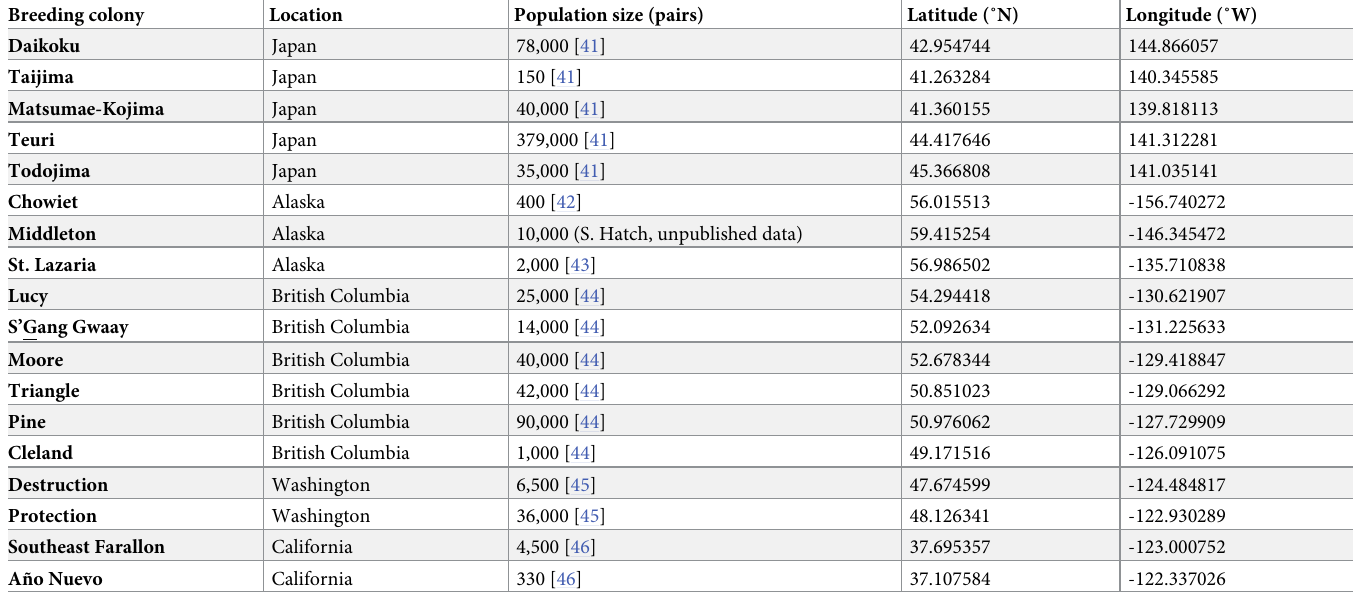
Table 1. Locations of rhinoceros auklet breeding colonies included in the genetics study, and the sizes of their breeding